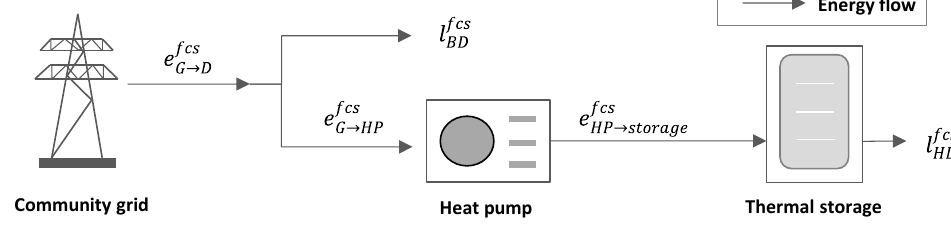
Figure 4. Energy flows in the flexible consumers’ model.